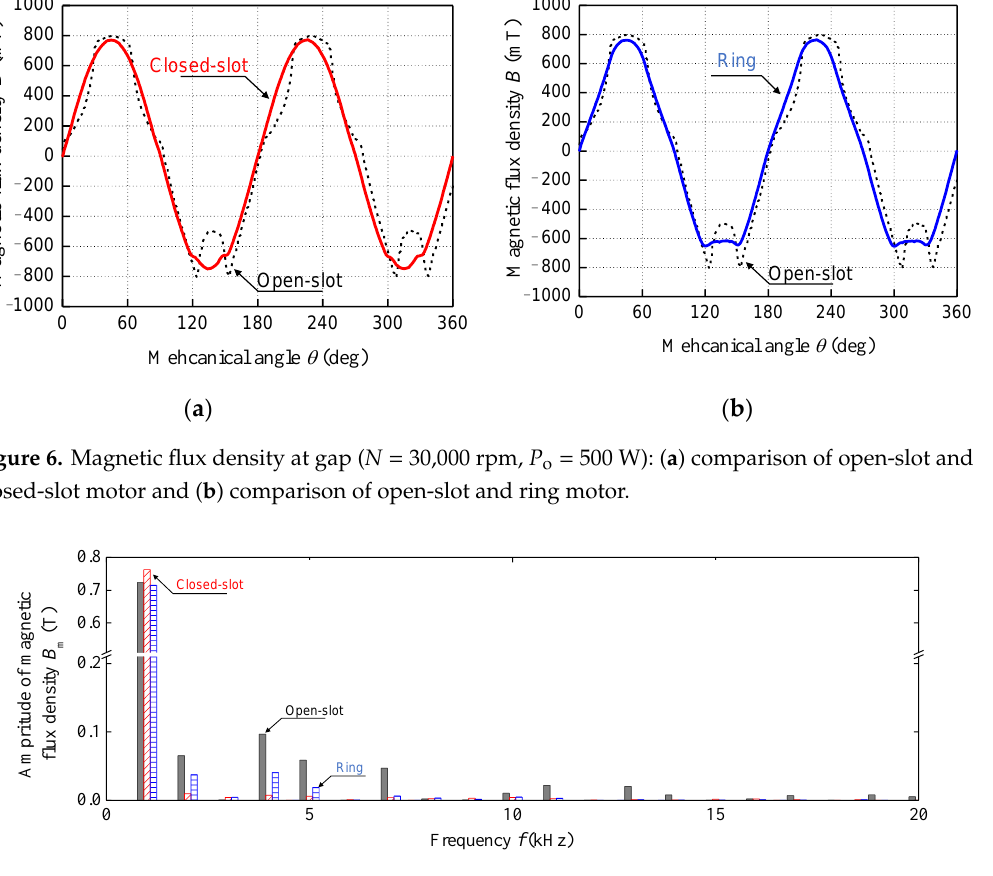
Figure 7. Spectrum of magnetic flux density ( N = 30,000 rpm, P o = 500 W): ( a ) open-slot motor, ( b ) closed-slot motor, and ( c ) ring motor.